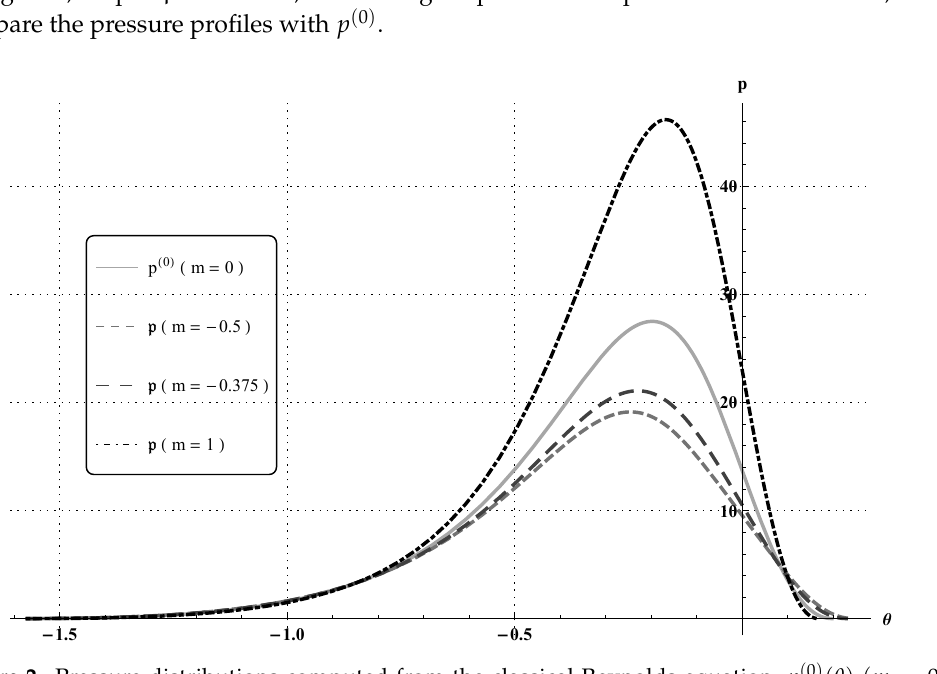
Figure 2. Pressure distributions computed from the classical Reynolds equation, p ( 0 ) ( θ ) ( m = 0 ) , and from the power-law system of Reynolds type equations, p ( θ ) ( m = − 0.5, − 0.375,1 ) , with (cid:101) = 0.1 and α 0 = O ( (cid:101) 3 ) .